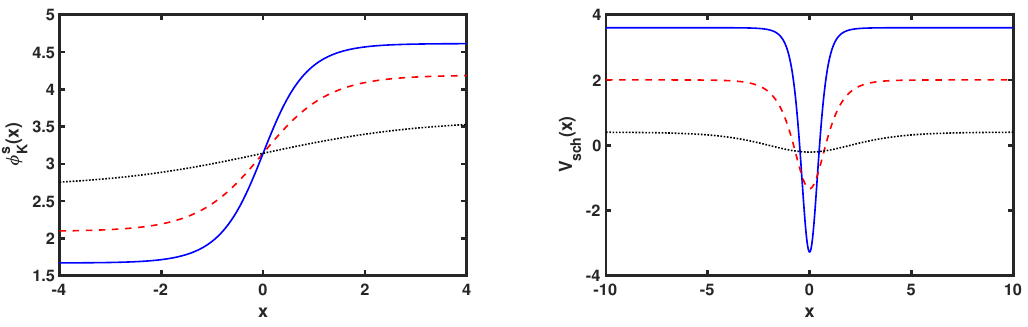
Figure 3 . (a) Small kink solutions φ s ( x ) and (b) corresponding Schrödinger-like potential V sch ( x ). K In the figures we fixed r = 0 . 1 (blue solid), r = 0 . 5 (red dash), r = 0 . 9 (black dot).